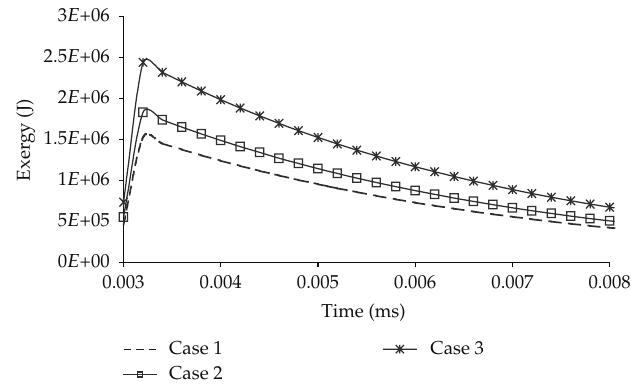
Figure 10: Exergy evolution as function of time with hydrogen mass fraction in